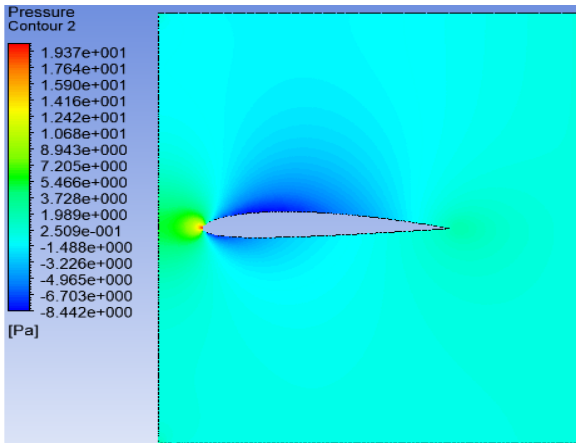
Figure 8. Pressure variation of NACA2415